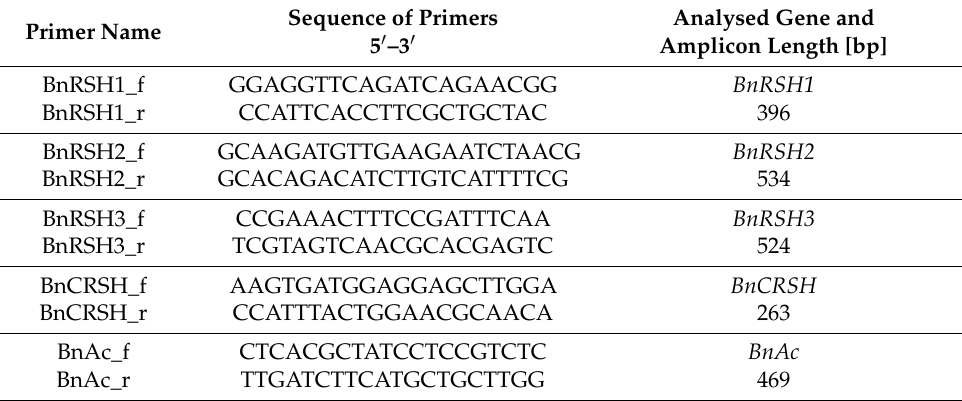
Table 2. Sequences of primers used for expression analysis of B. napus RSH